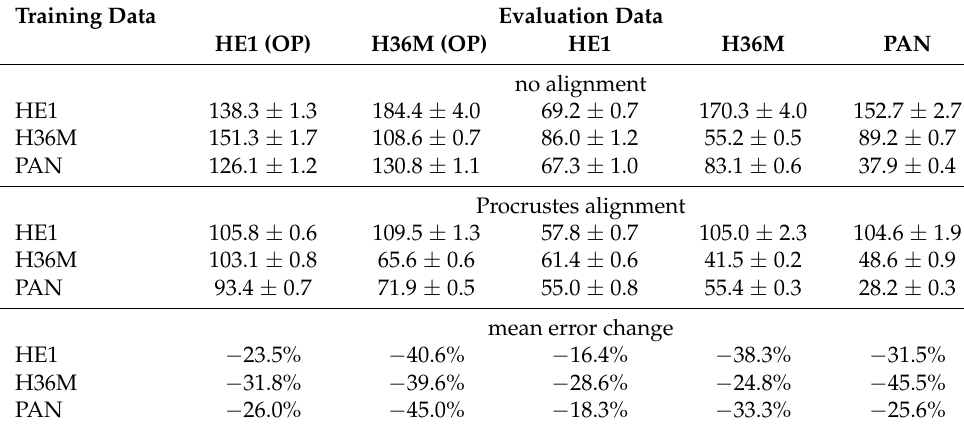
Table 12. Error (no alignment vs. Procrustes) with OpenPose 2D joints (OP) and ground truth joint projection, with scale normalization (errors in mm, mean ± std.